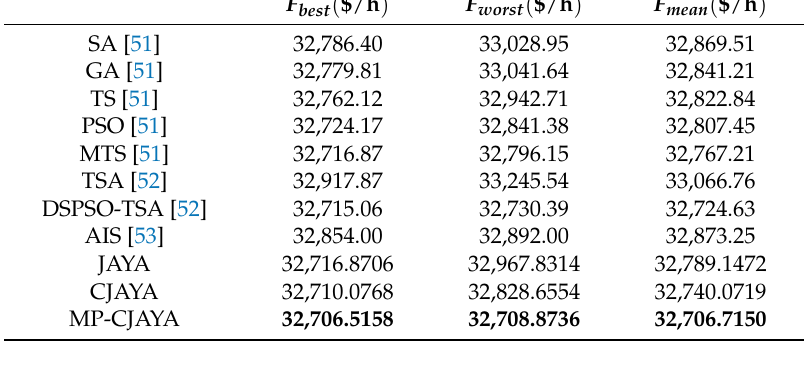
Table 8. Results comparison of 15-units system ( P D = 2630 MW).